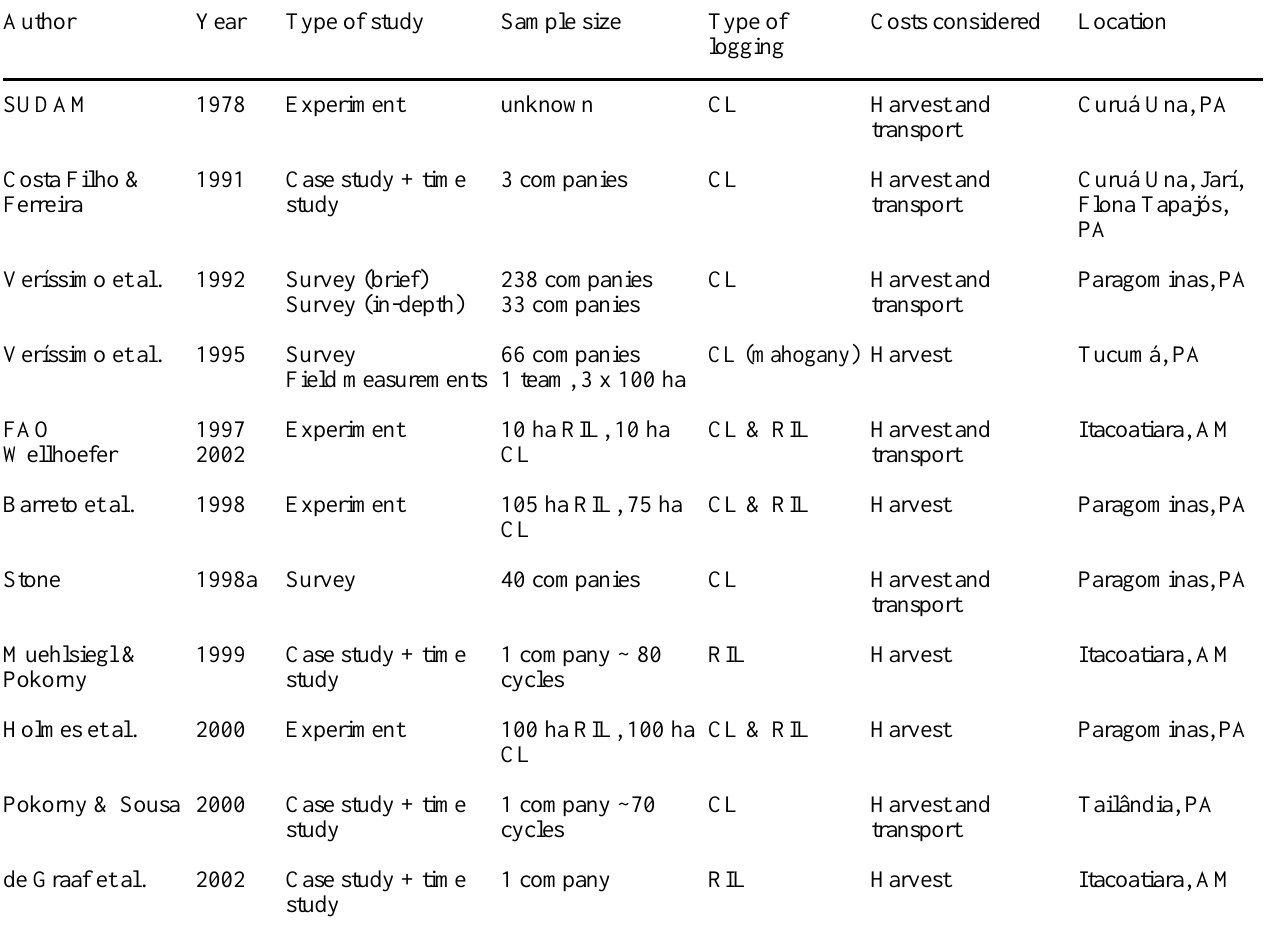
Table 1 . Characteristics of selected research on financial aspects of commercial timber harvest (RIL and CL) in the Brazilian